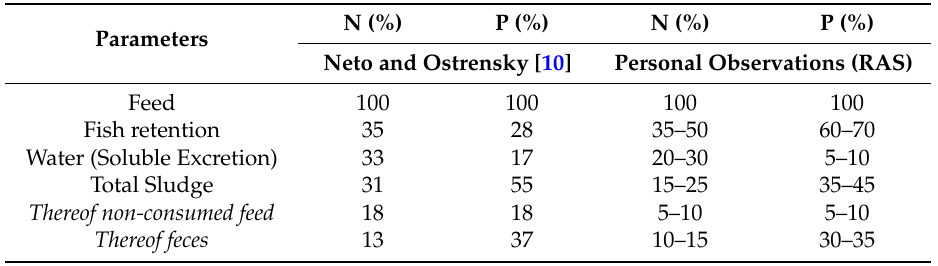
Table 5. Nitrogen (N) and phosphorous (P) flow from Nile tilapia feeding in RAS cage